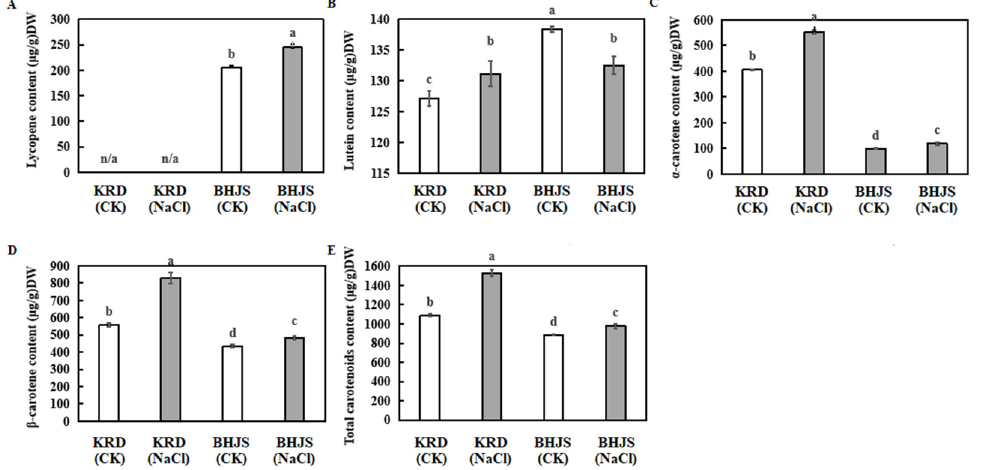
Figure 4. Carotenoids concentration in different carrot cultivars and treatments. ( A ) Lycopene con- centration in the roots of ‘BHJS’ and ‘KRD’ under different treatment; ( B ) Lutein concentration; ( C ) α -carotene concentration; ( D ) β -carotene concentration; ( E ) Total carotenoids concentration. Cultivar abbreviations: BHJS, Benhongjinshi; KRD, Kurodagosun. “n/a” represents no concentration was detected. Different lowercase letters indicate significant differences among different carrot cultivars and treatment at the p < 0.05 level.